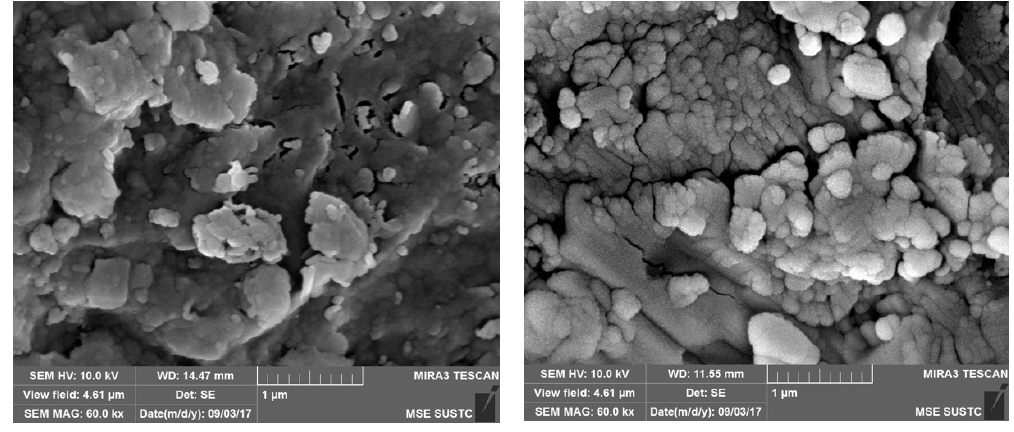
Figure 2. SEM images of the sludge ceramsite before ( left ) and after ( right ) it was roasted.